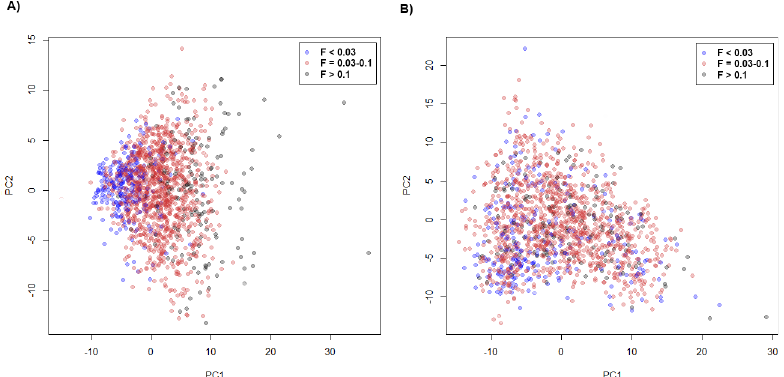
Fig 1. Principal component analysis of Jersey cattle using ROH (A) and SNP genotypes (B). Principal component 1 (PC1, x axis) and principal component 2 (PC2, y axis) are plotted. Three groups that are classified based on inbreeding coefficient (FPED) are indicated with three different colors. Blue, red, and black circles represent individuals with FPED < 0.03, FPED = 0.03 – 0.10, and FPED > 0.10,